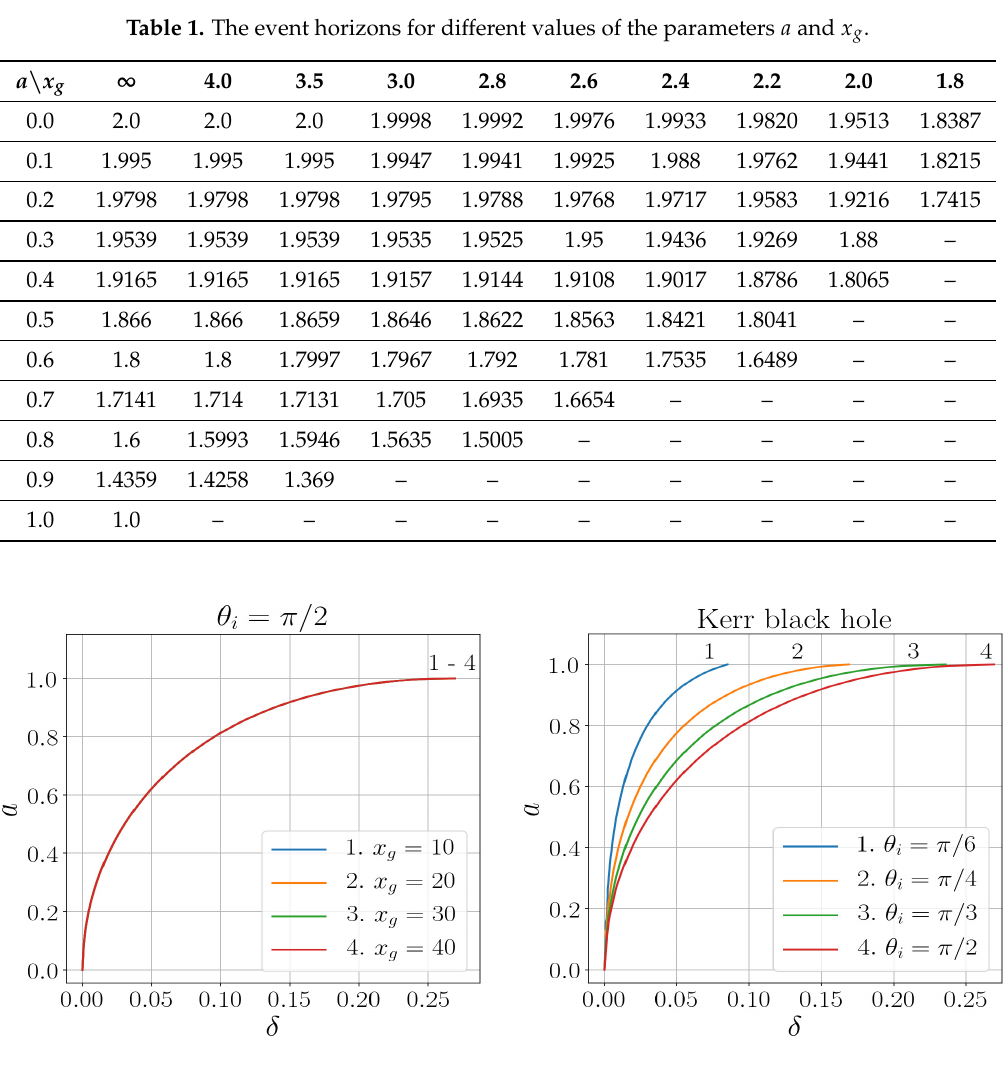
Figure 3. Left : Relation between spin and distortion parameter for an observer with θ i = π /2. Right : Relation between spin and distortion parameter for the Kerr black